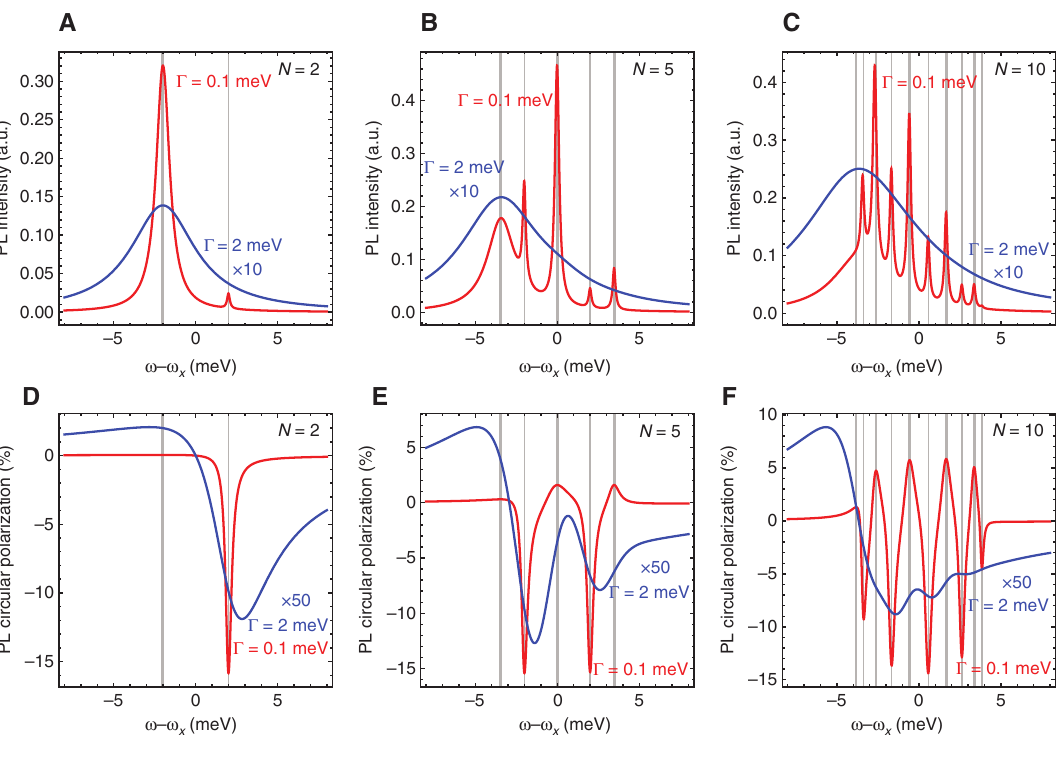
Figure 6: Photoluminescence of chiral